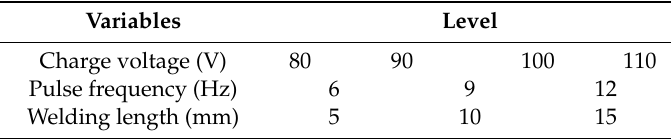
Table 2. Variables for testing the tensile strength.